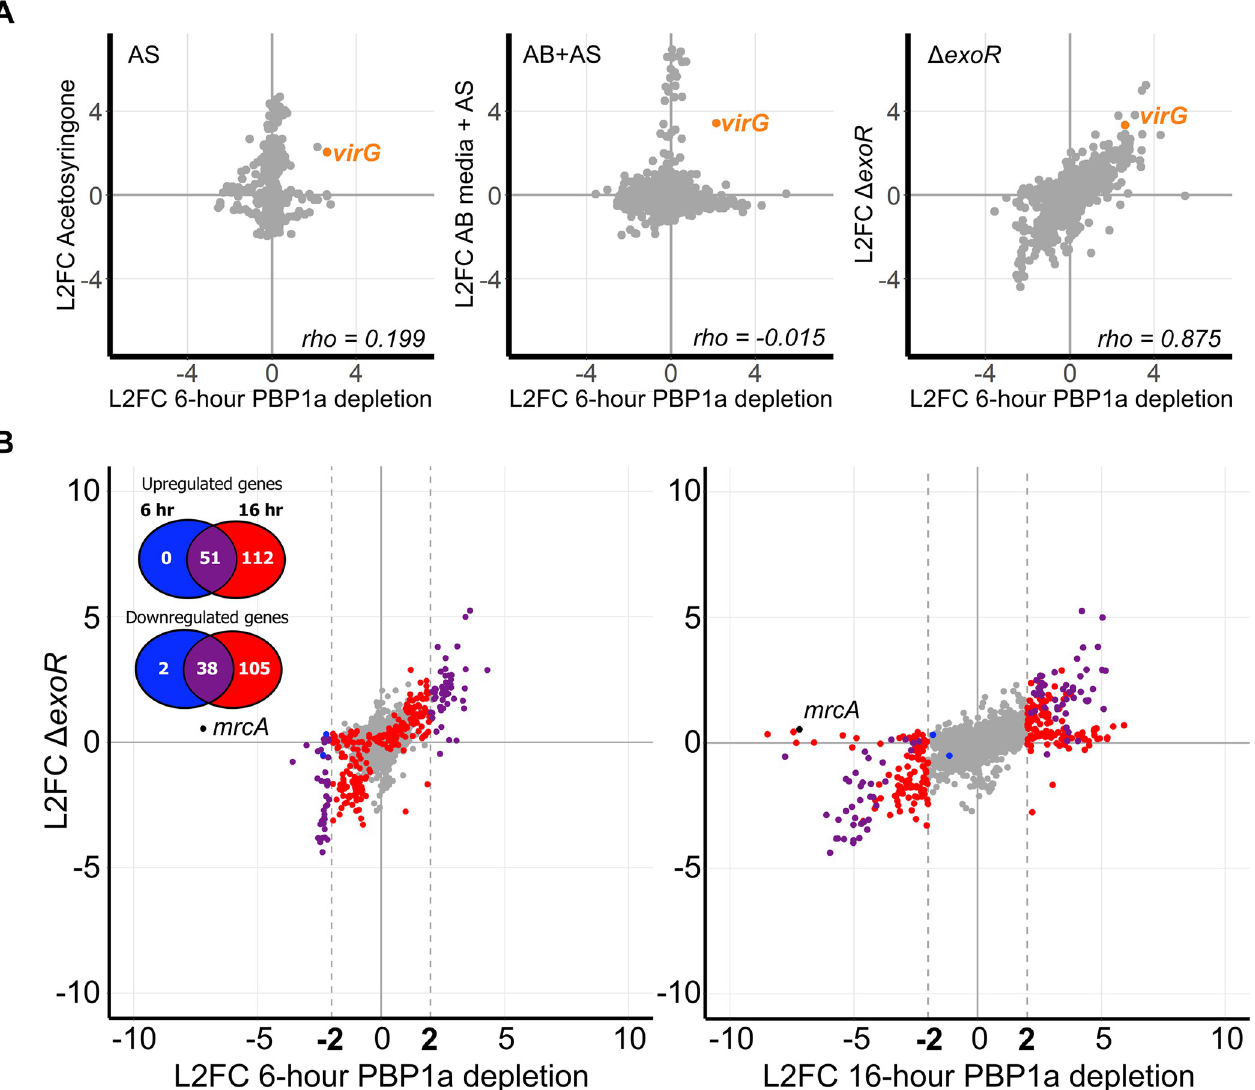
Fig 3. The response to the depletion of PBP1a mimics transcriptional changes associated with host invasion. A. Correlation scatterplots depicting relationships between the log2fold-change (L2FC) values in the 6-hour PBP1a depletion and transcriptomic data sets taken under simulated virulence-inducing conditions (AS and AB+AS) and under simulated host-invading conditions ( Δ exoR ). Each point represents a unique transcript. AS, acetosyrinogone; AB, Agrobacterium minimal media; rho, Spearman correlation coefficient. B. Correlation scatterplots comparing L2FC values of transcripts in the Δ exoR microarray to either the 6-hour or 16-hour PBP1a depletion. Each transcript is colored according to its change in L2FC values from 6 hours of PBP1a depletion to 16 hours of depletion. Gray, no change; Blue, transcript has |L2FC| > 2.0 in the 6-hour but not in the 16-hour depletion; Red, |L2FC| > 2.0 in the 16-hour but not in the 6-hour depletion; Purple, |L2FC| > 2.0 in both the 6-hour and 16-hour